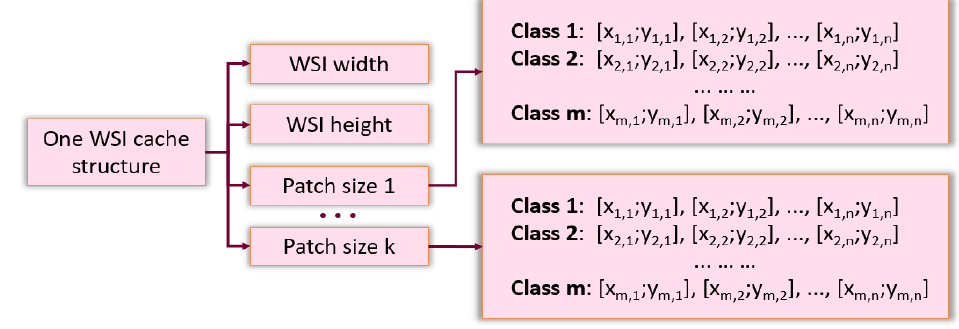
Figure 2. The structure of cache system.